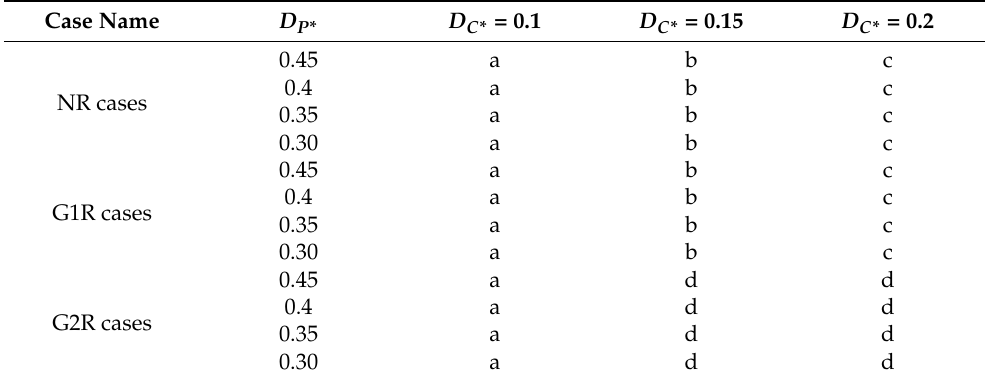
Table 3. Flow structure